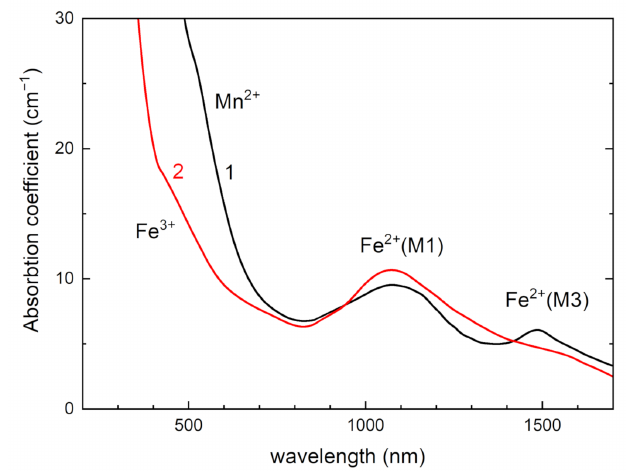
Figure 8. Optical absorption spectra of tinaksite ( 1 ) and tokkoite ( 2 ).